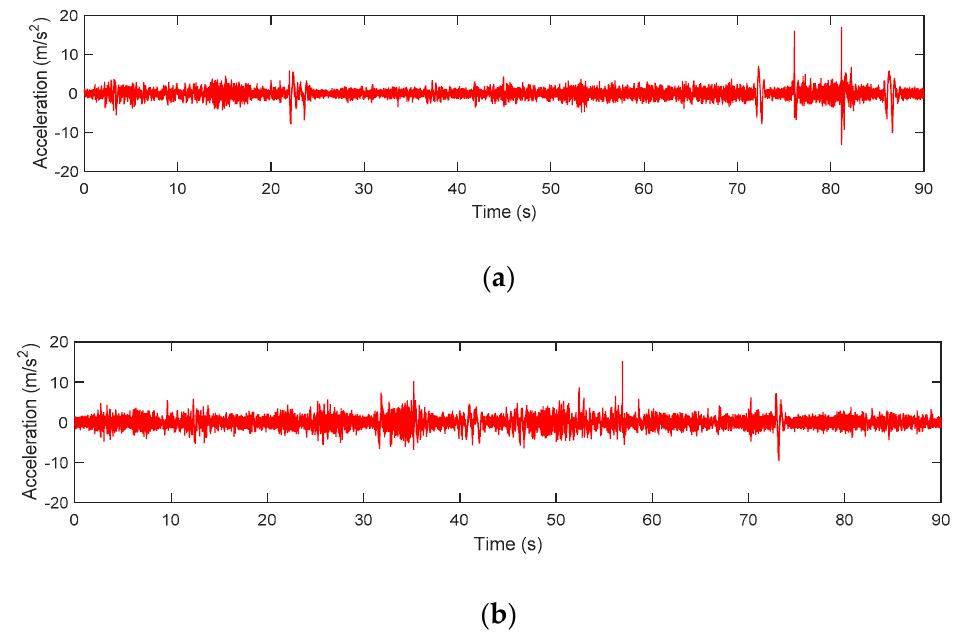
Figure 10. Top mount acceleration signals: ( a ) Rural A, ( b ) Rural B.